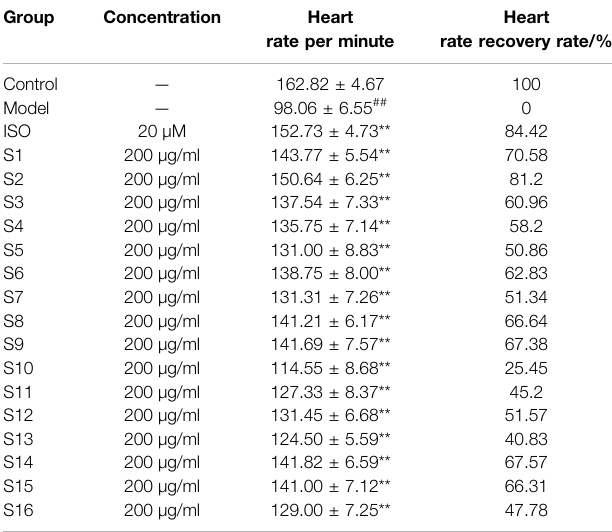
TABLE 1 | Heart rate recovery rate of zebra fi sh larvae treated with XKST. Group Concentration Heart